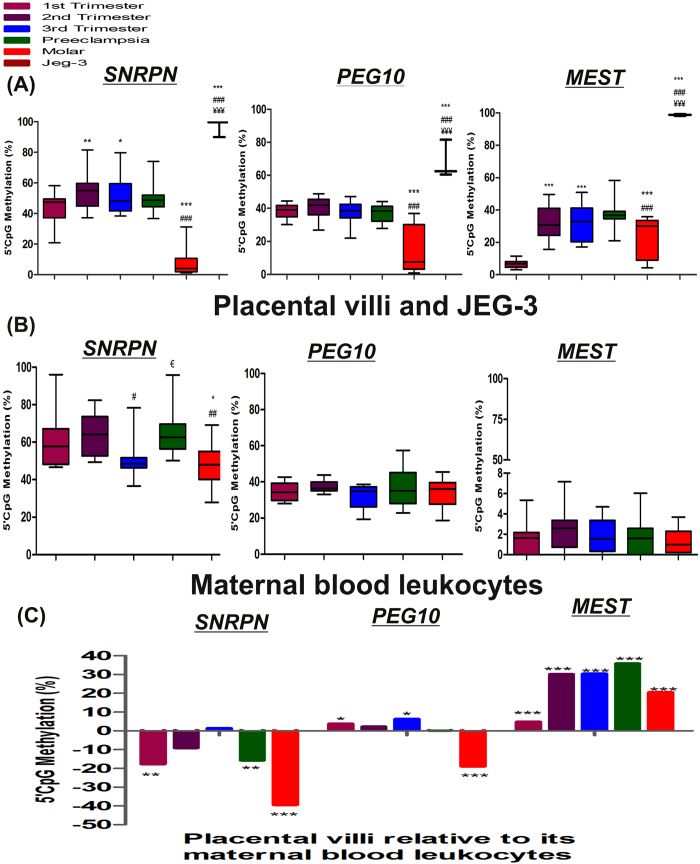
DNA methylation at DMRs of imprinting genes.(A) Box-and-whisker plot to show % CpG methylation among different placental villous samples and JEG-3 cells, (B) Box-and-whisker plot to show % CpG methylation among maternal blood leukocytes [*p < 0.05, **p < 0.01, ***p < 0.001 vs 1st trimester, #p < 0.05, ##p < 0.01, ###p < 0.001 vs 2nd trimester, €p < 0.05 vs 3rd trimester and ¥¥¥p < 0.001 vs molar], and (C) % CpG methylation in villous samples in reference to their corresponding maternal blood leukocytes [*p < 0.05, **p < 0.01,***p < 0.001]. n = 30 per group.